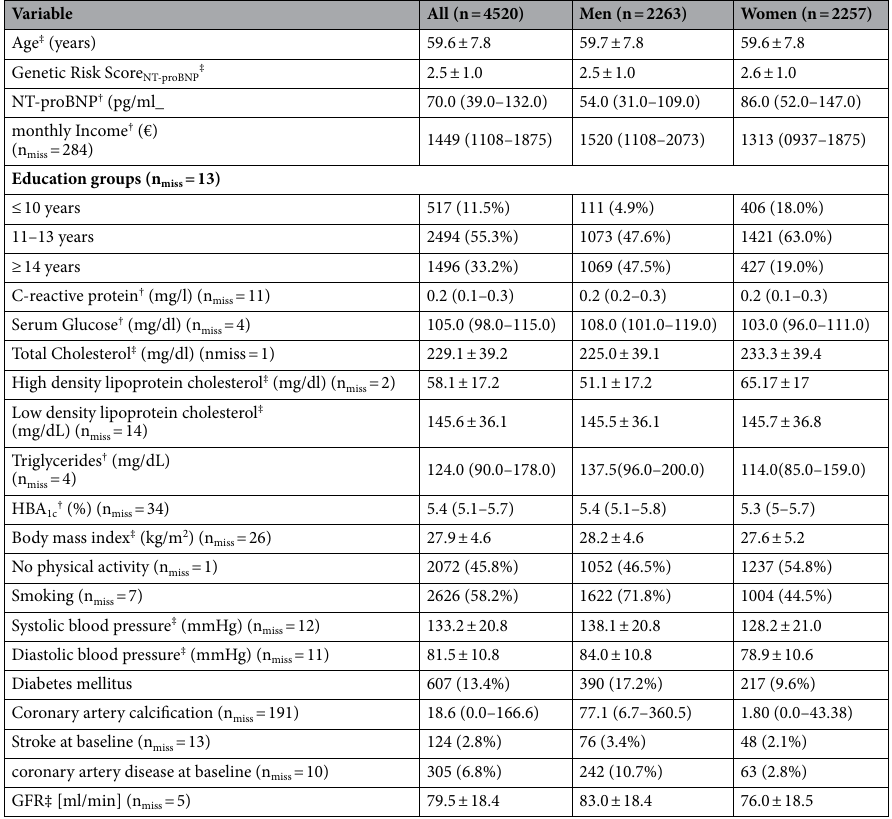
Table 2. Description of analysis population. ‡ Mean ± standard deviation. † Median (first quartile − third quartile). n miss = missing